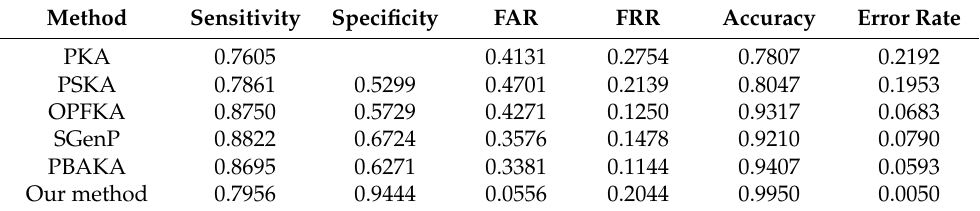
Table 5. The proposed method experimental results compared with other